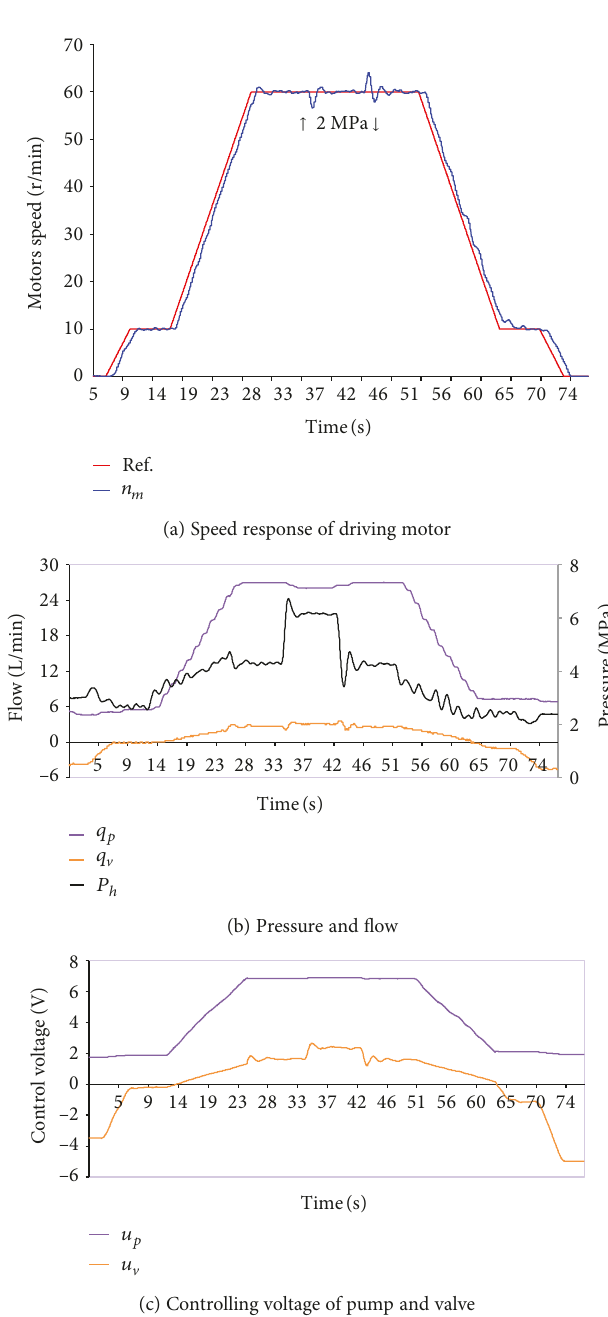
Figure 8: Dynamic response in a speed regulation